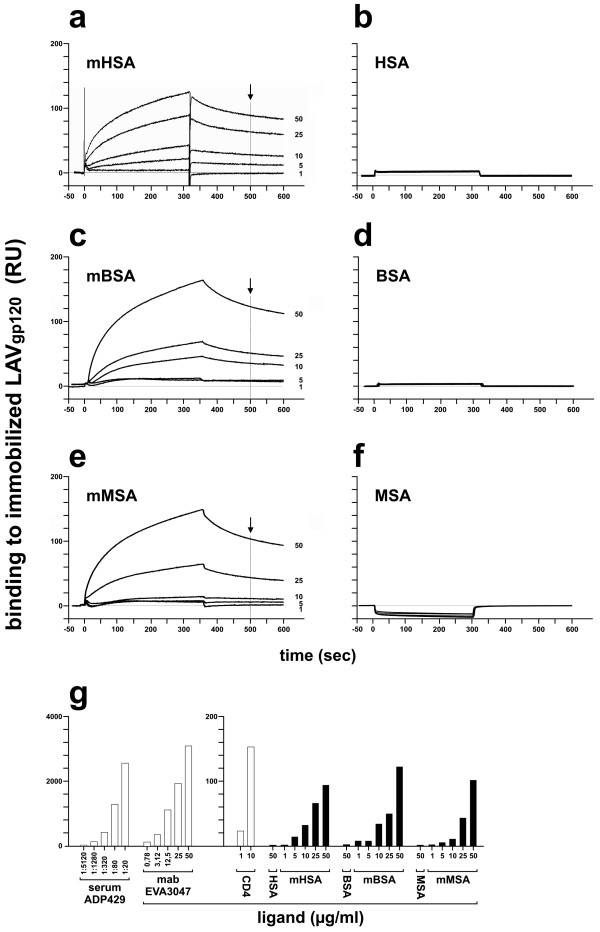
Binding of HOCl-modified serum albumins to gp120. (a-f) Binding of HSA, BSA, MSA and HOCl-modified albumins mHSA, mBSA, mMSA (protein:HOCl molar ratio 1:1000) to LAV-gp120 was tested by surface plasmon resonance spectroscopy (Biacore 1000, GE Healthcare). Purified LAV gp120 (10 μg/ml, Protein Sciences Corporation) was covalently linked using EDC/NHC to a dextran coated, CH-activated sensor chip (CM5, GE Healthcare). After blocking with ethanolamine the biosensor was washed three times with 30 μl 100 mM NaOH and 30 μl 100 mM HCl (flow rate 5 μl/min). Proteins were tested for binding at 1, 5, 10, 25 and 50 μg/ml at a flow rate of 5 μl/min. (g). Binding of mHSA, mBSA and mMSA (values marked by the black arrow in Figure 1a, 1c and 1e) was compared to the binding of CD4, and gp120-specific antibodies to a LAV gp120 coated CM5 biosensor. ADP429: anti-serum, derived from HIV-1 SF2 gp120-immunized sheep (AIDS reagent project, NIBSC, UK). EVA3047: monoclonal antibody, derived from IRIQRGPGRAFTIGC-peptide immunized mice (AIDS reagent project, NIBSC, UK).